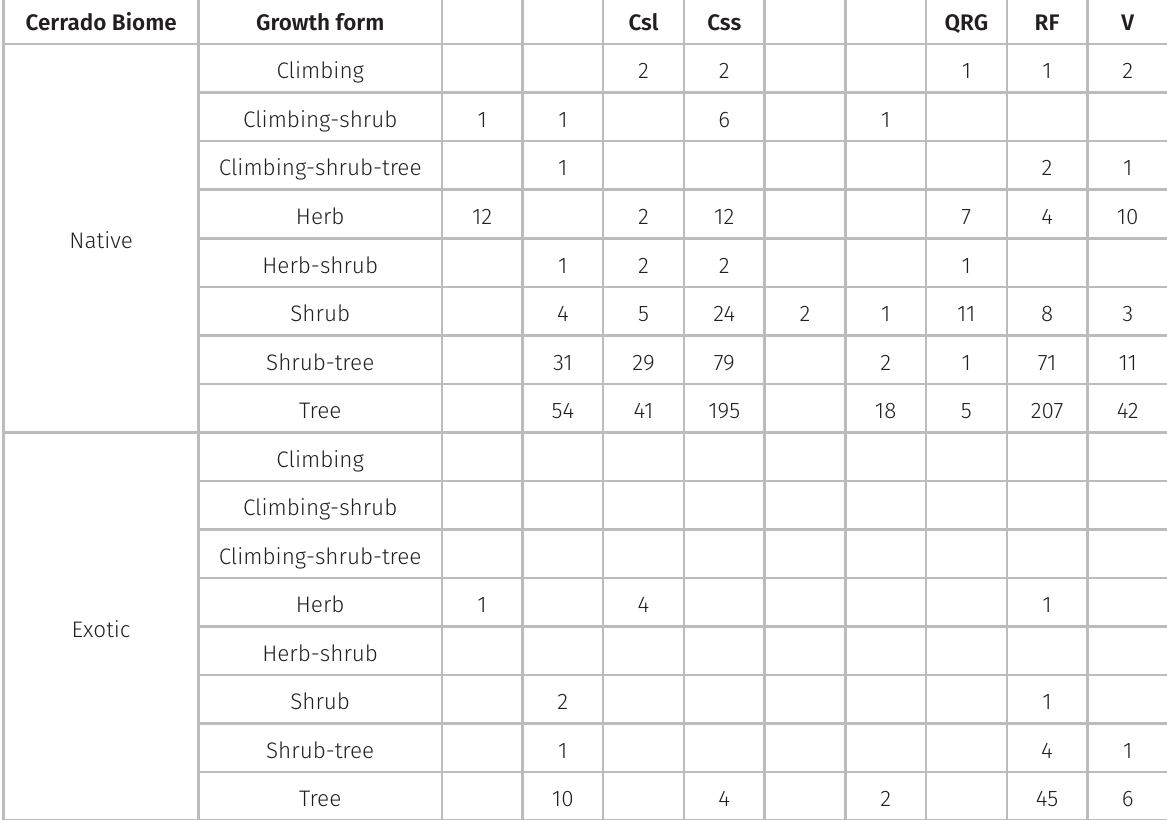
Table V. The frequency of plant species growth forms used in ecological restoration of Cerrado vegetation types: CC ( campo cerrado ), C ( cerradão ), Csl ( cerrado sensu lato ), Css ( cerrado sensu stricto ), IO (ironstone outcrop), MS ( mata seca) , QRG (quartzitic rupestrian grassland), RF (riparian forest), and V ( vereda ). Plant species are classified according to their occurrence in the Cerrado biome (native or